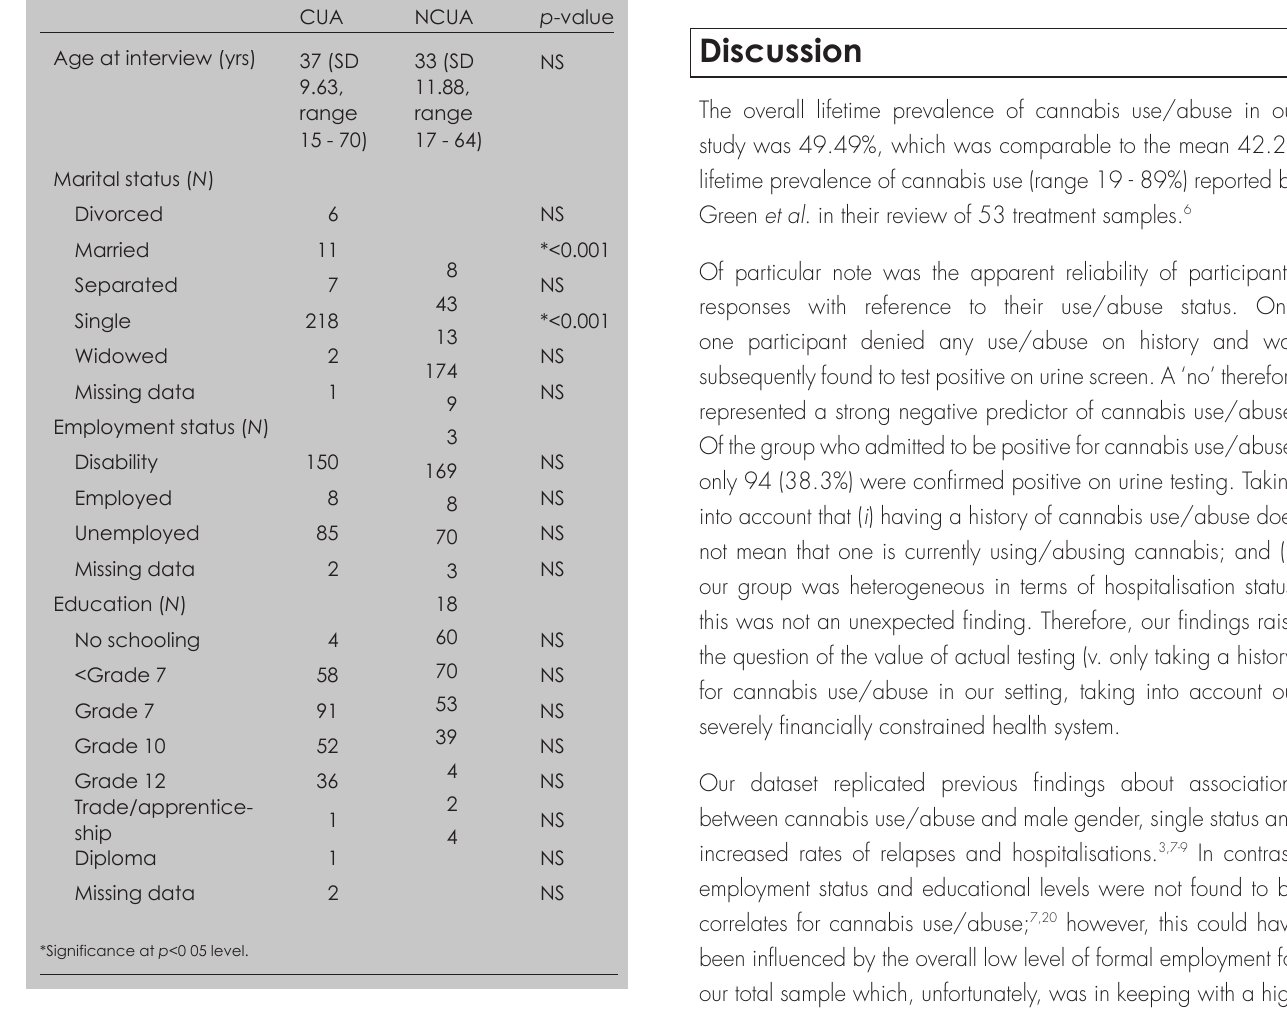
Table II. Comparison of illness variables between CUA and NCUA groups